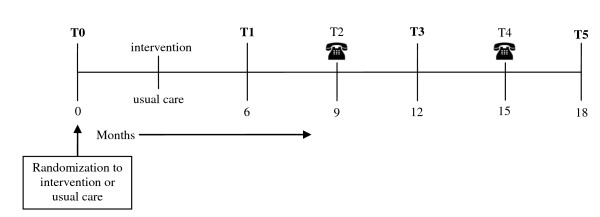
Timeline study procedure. The figure shows a timeline of the study procedure.